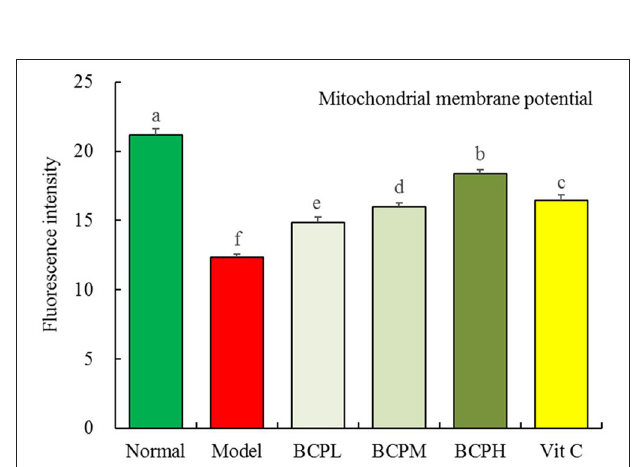
FIGURE 10 | Effect of BCP on Mitochondrial membrane potential of H9c2 cells with OS injury. a − f Mean values with different letters over the bar are significantly different ( P < 0.05) according to Tukey’s honestly significant